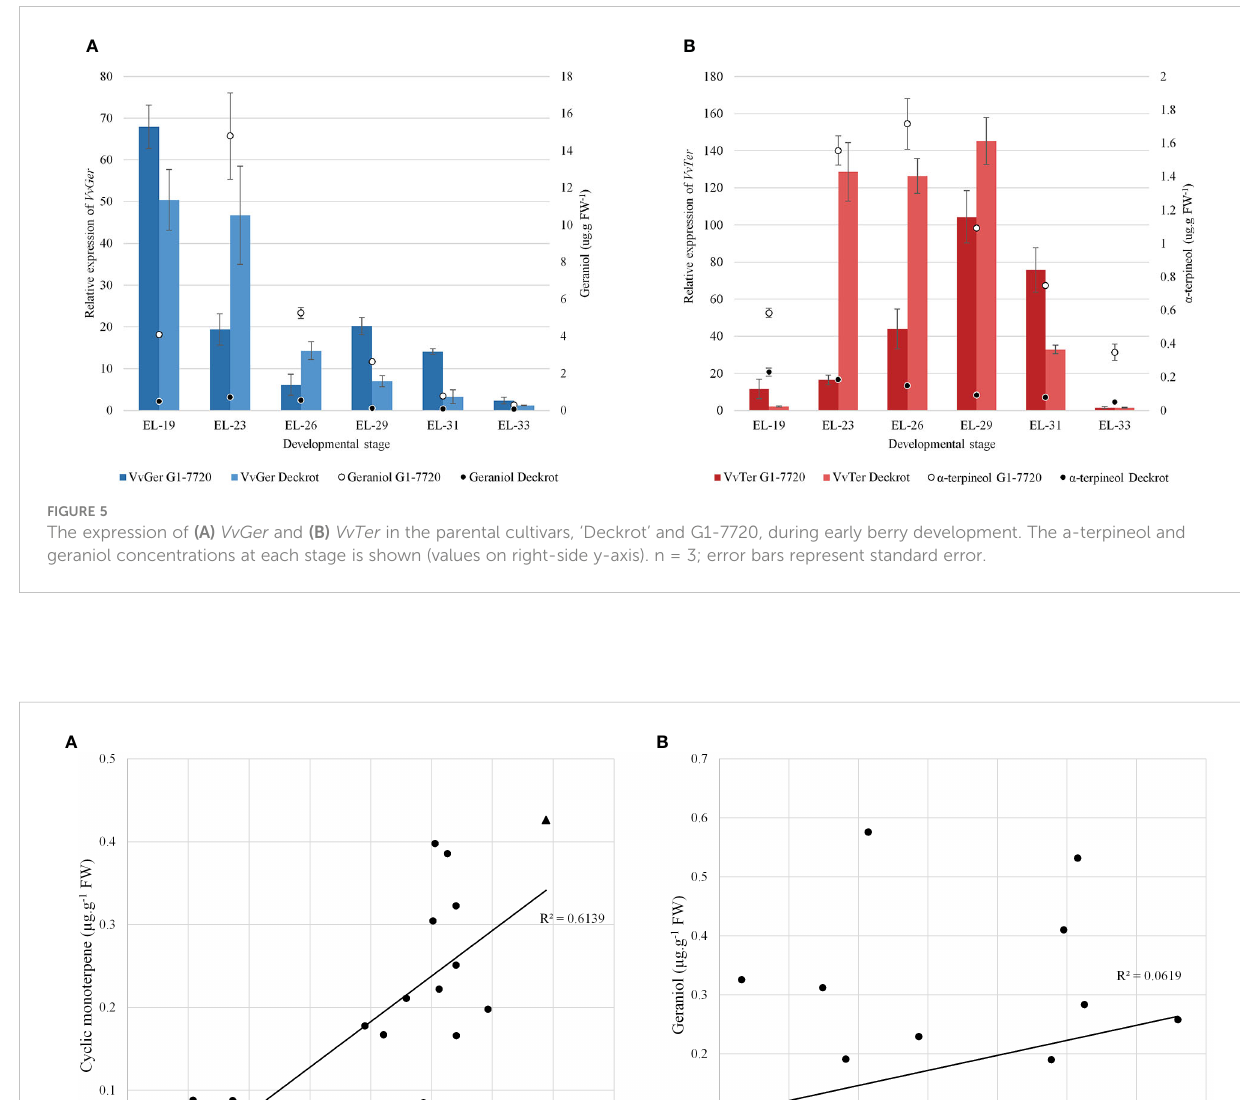
TABLE 2 The number of unique VvTer and VvGer cDNA clones that were identi fi ed for ‘ Deckrot ’ and G1-7720. Parent cultivar Gene of interest cDNA clones sequenced unique cDNA sequences Putatively functional